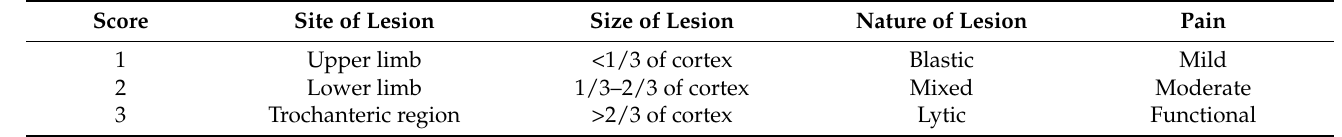
Table 1. The Mirels scoring system. Adapted from